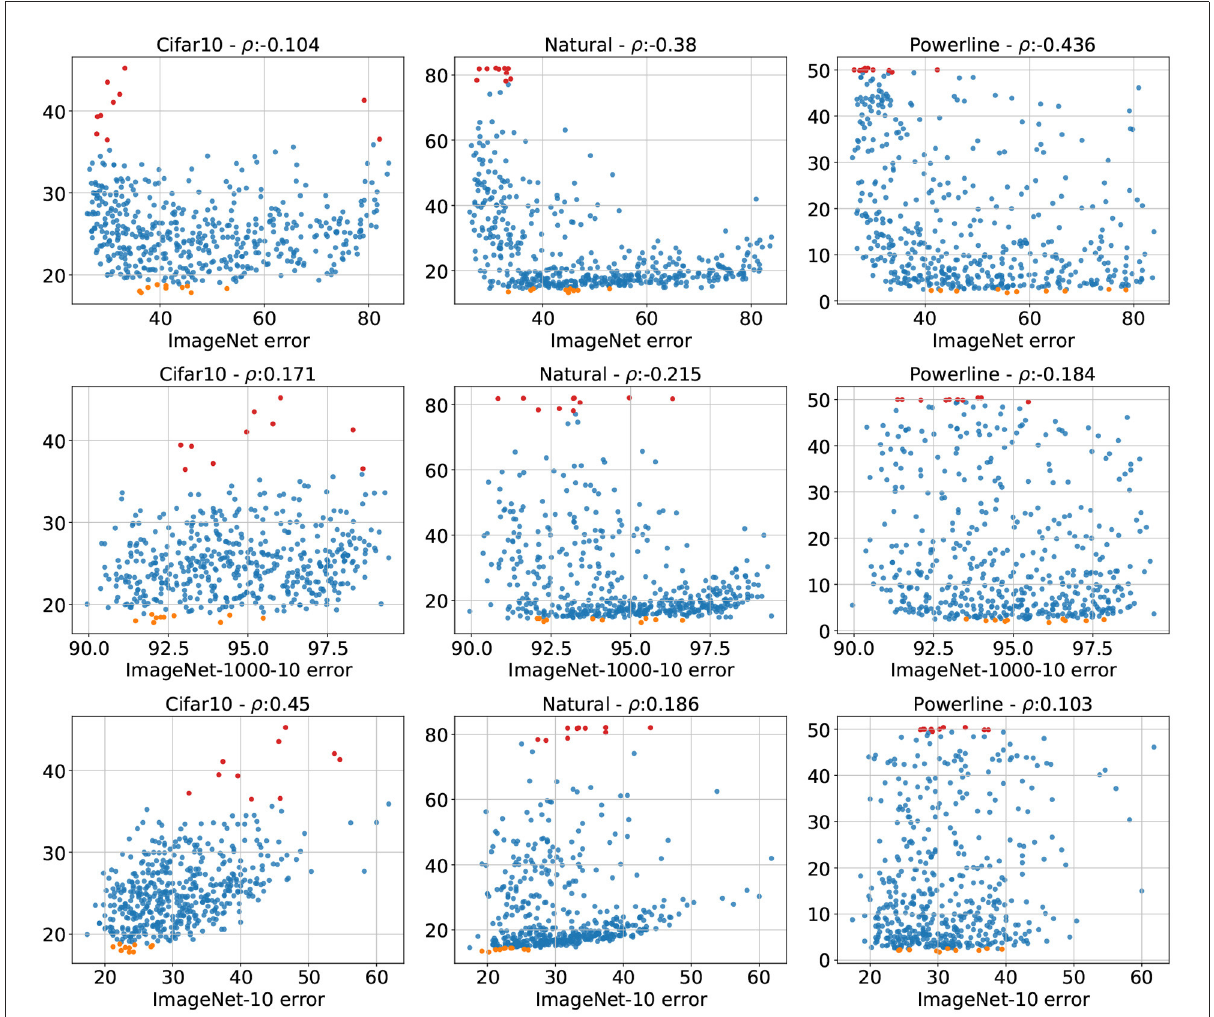
FIGURE6 The errors of all 500 architectures on Cifar10, Natural, and Powerline plotted against the errors on ImageNet (top row) , ImageNet-1000-10 (middle row) and ImageNet-10 (bottom row) . We observe that class-wise downsampling has the largest positive effect on error correlation.